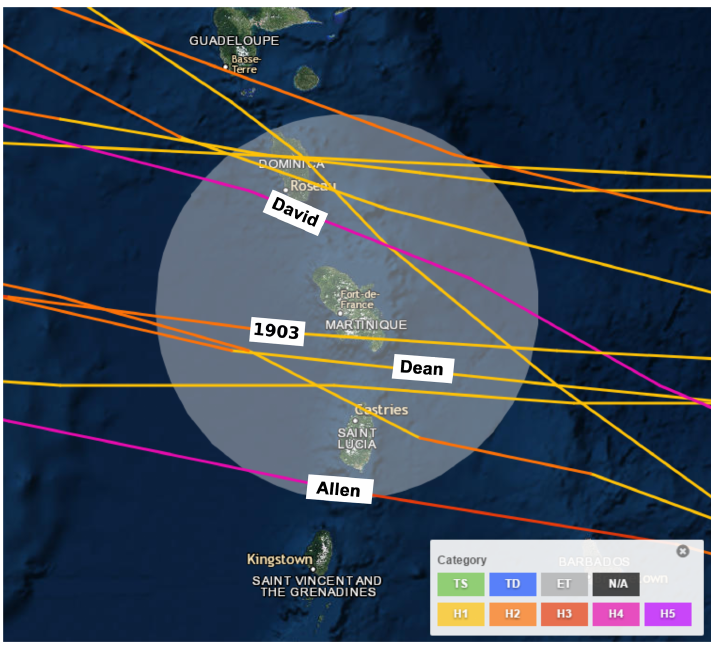
Figure 2. Tracks and intensities of historical hurricanes passing within 65 nautical miles from Martinique, since 1900. (source: NOAA’s Office for Coastal Management,